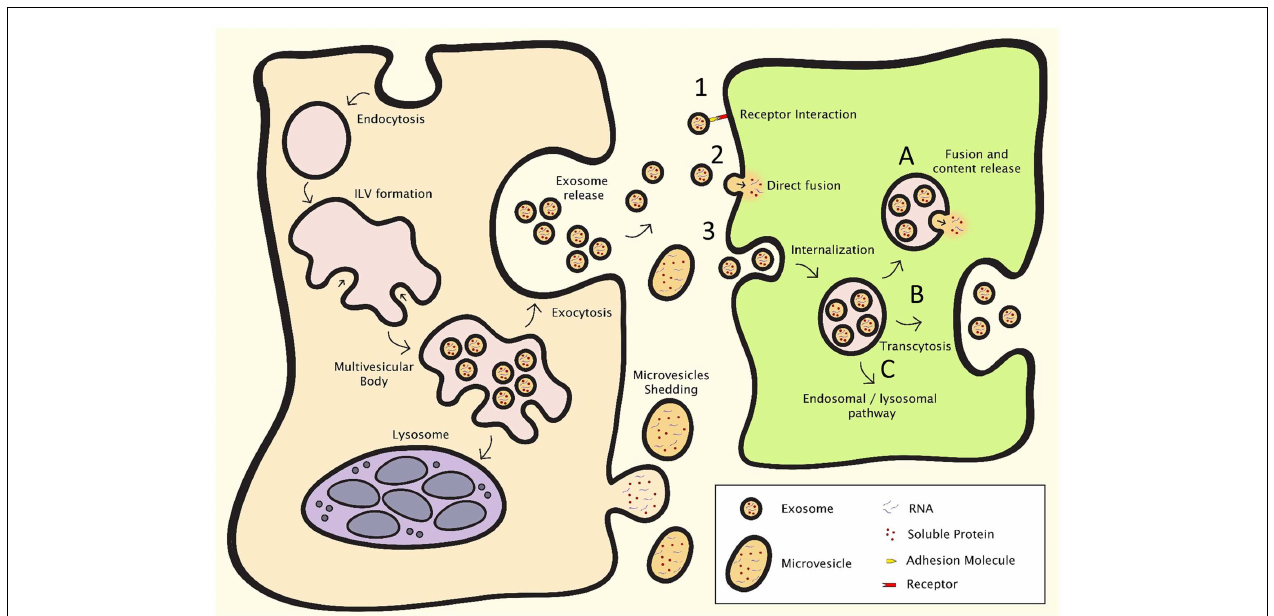
FIGURE 2 | EV formation (left) and intercellular communication (right) . After endocytosis, intraluminal vesicle formation occurs in the late endosome, resulting in the formation of the multivesicular body (MVB).The MVB can either fuse with the lysosome, resulting in breakdown and recycling of its contents, or fuse with the plasma membrane, resulting in the release of the intraluminal vesicles, which are then deemed exosomes. Microvesicles shed directly from the plasma membrane.